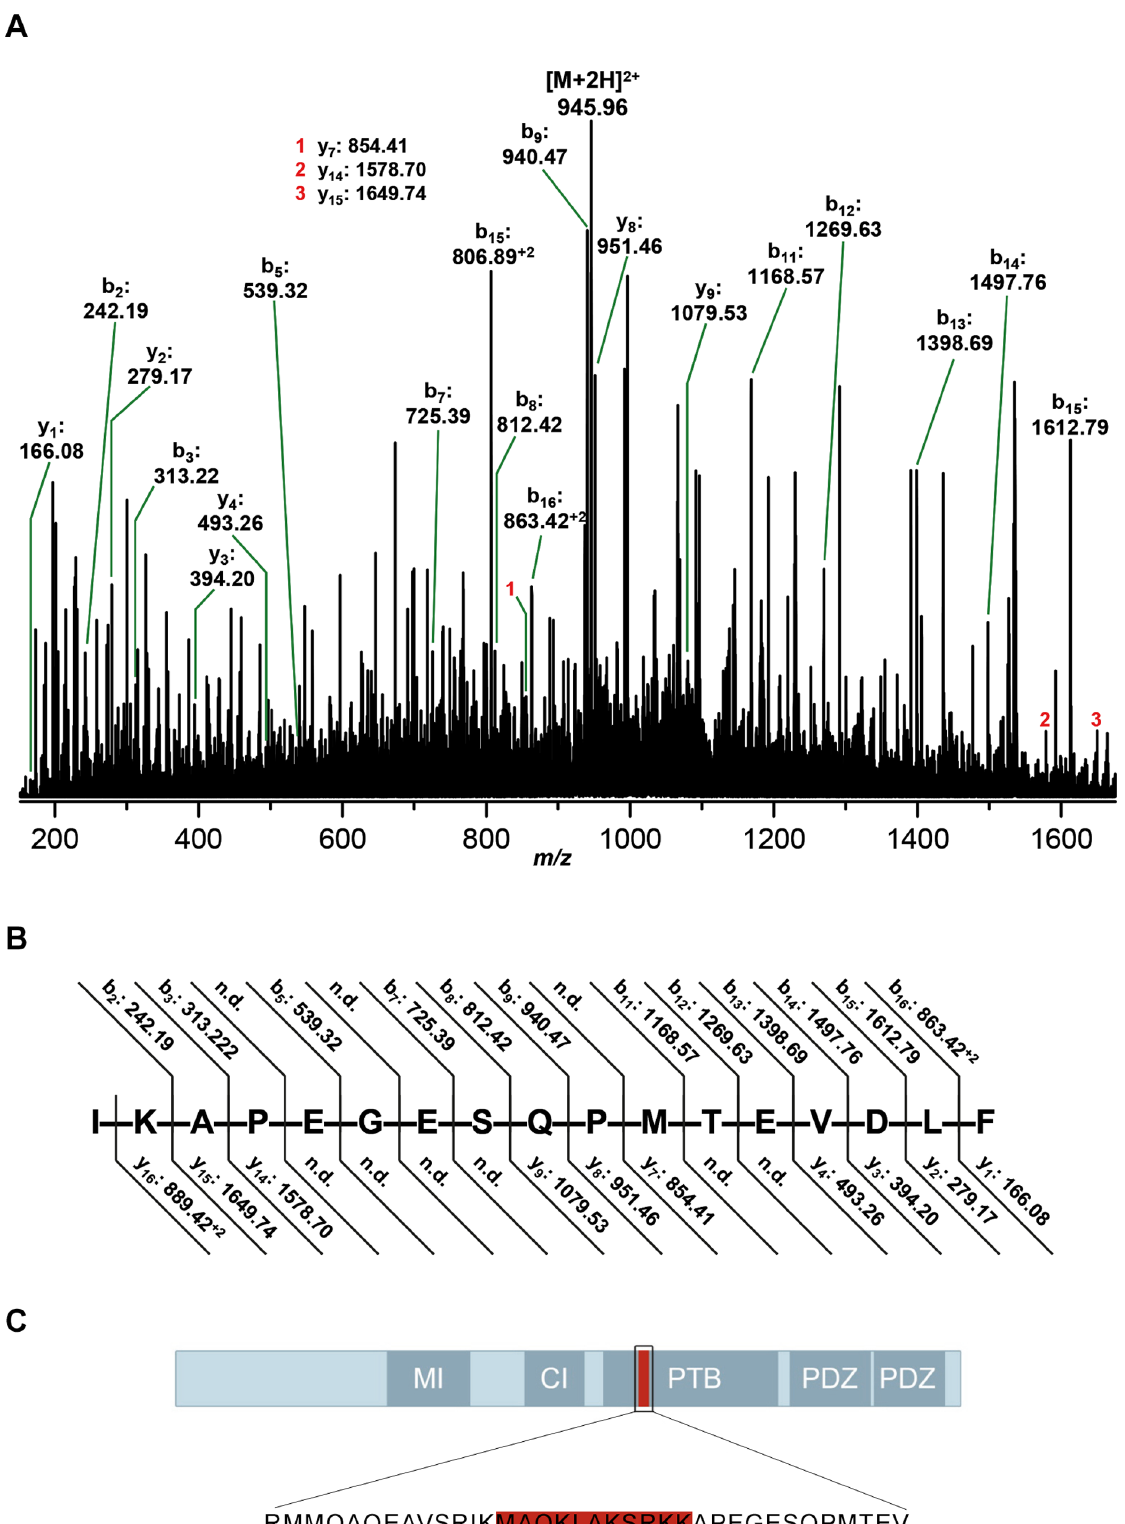
Figure 6. Detection of Mint 826 by mass spectrometry. A) NanoESI fragment ion spectrum obtained from a CID experiment on the ion mobility-separated doubly charged peptide precursor ions at m/z 945.96 derived from an in-gel proteolytic digest by thermolysin of immuno- precipitated Mint1 826 protein. B) Corresponding fragmentation scheme. C) Schematic illustration of both Mint1 isoforms. Highlighted in red: 11 aa sequence deleted in Mint1 826.